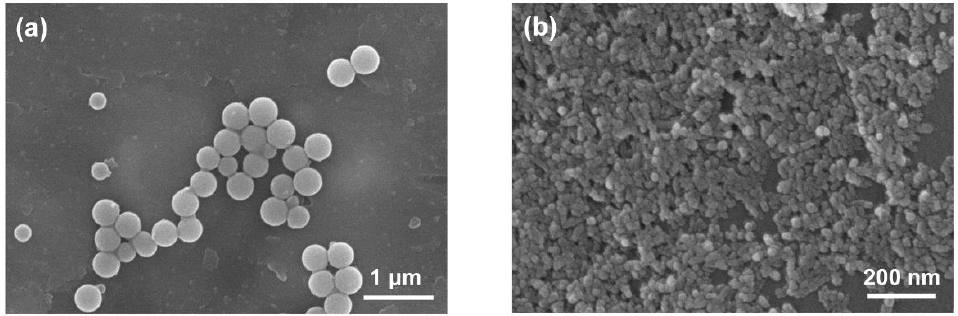
Figure 3. FE-SEM images of ( a ) ROIN-Si and ( b ) ROIN-Al nanoparticles.